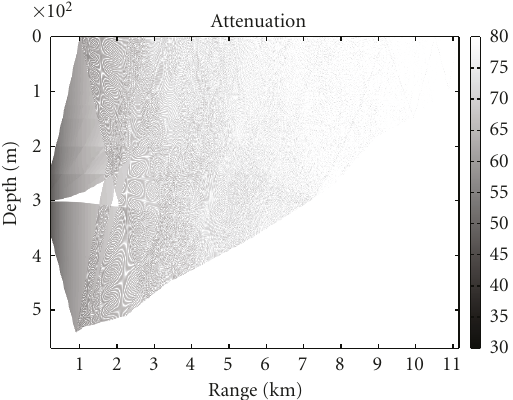
Figure 9: Attenuation incurred by acoustic waves at 4 kHz trans- mitted in August approximately 20km o ff shore Taranto harbor, 40 . 32 ◦ N, 17 . 12 ◦ E. A darker shade of grey represents a stronger signal. Surficial sediments are a mixture of sand and clay; a sharply increasing sea bottom profile can be seen in the lower half of the picture.